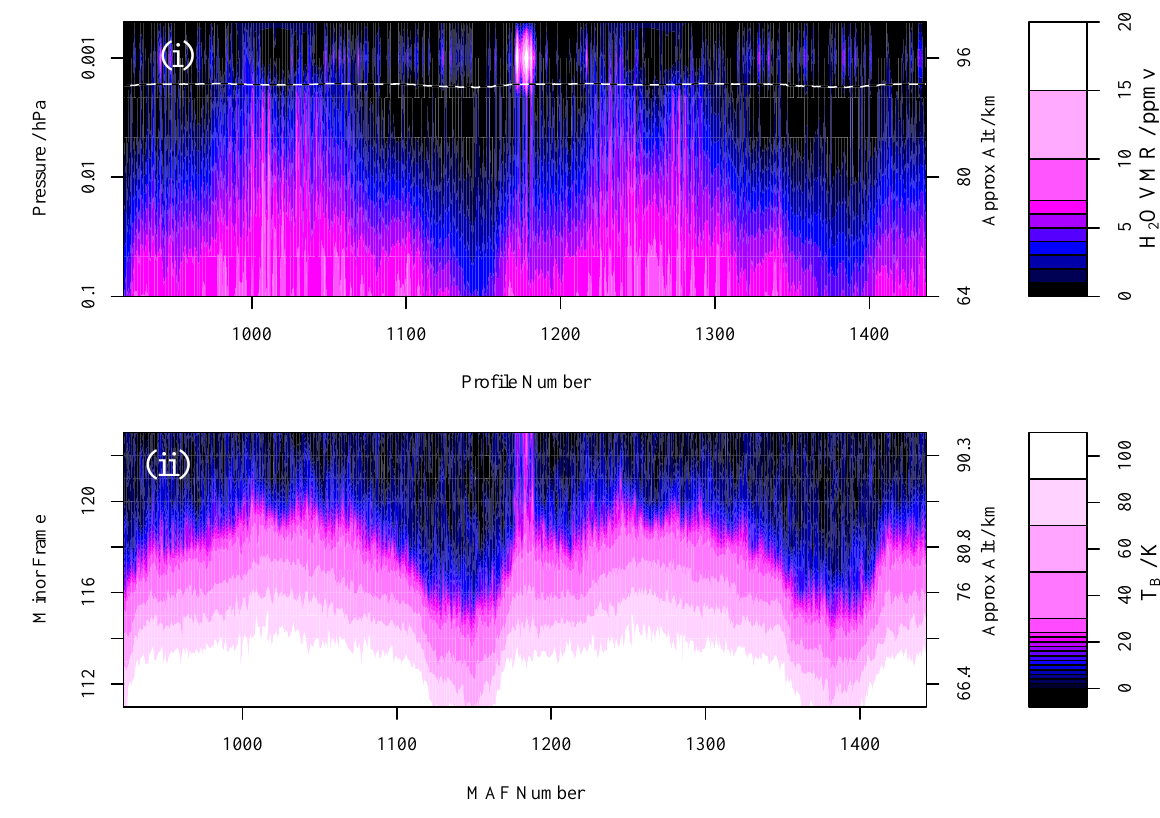
Fig. 1. Two orbits of MLS data in the mesosphere on 10 December 2006. The measurement location passes through 27 ◦ N heading southwards near the left-hand side, at the centre and near the right-hand side, that is, near profiles 936, 1176 and 1416. Panel (i) shows retrieved H 2 O mixing ratio in parts per million by volume (ppmv). Panel (ii) shows radiance (as Rayleigh-Jeans brightness temperature T B in K) averaged over the line centre region of the DACS. Retrieved profiles do not coincide exactly with limb scans (major frames or MAFs) for reasons described by Livesey et al. (2006), the profiles in (i) are aligned with the closest limb scan in (ii). The dashed line in (i) marks the upper boundary of the region in which the level 2 H 2 O data are regarded as suitable for general use. The region of enhanced H 2 O and radiance in the centre of the plot lies between 18 ◦ N and 36 ◦